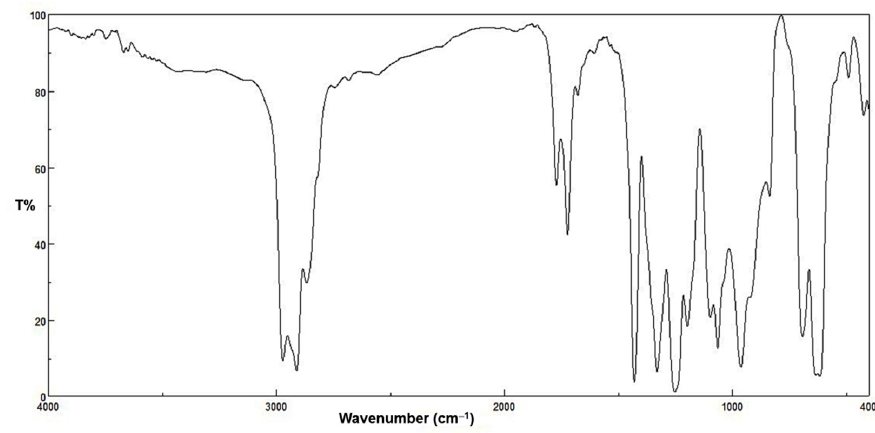
Figure 3. FTIR spectrum of PVC film after irradiation for 250 h.